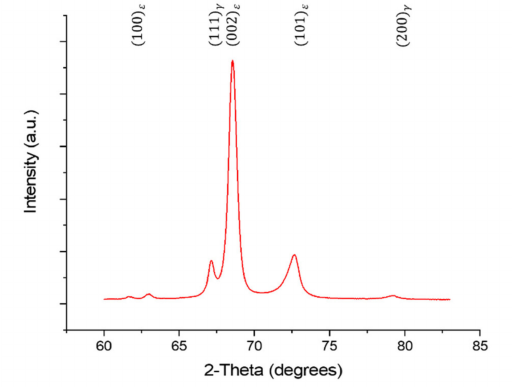
Figure 5. X-ray diffraction profile obtained at ~400 µ m from the quenched